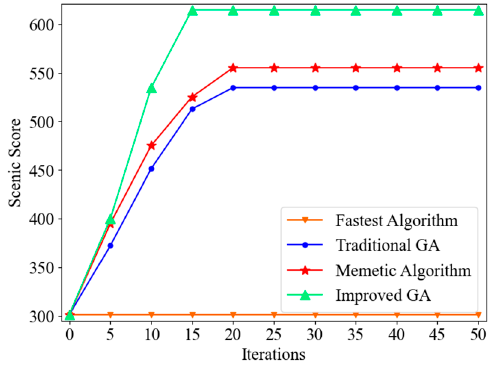
Figure 6. Number of gene replacements.